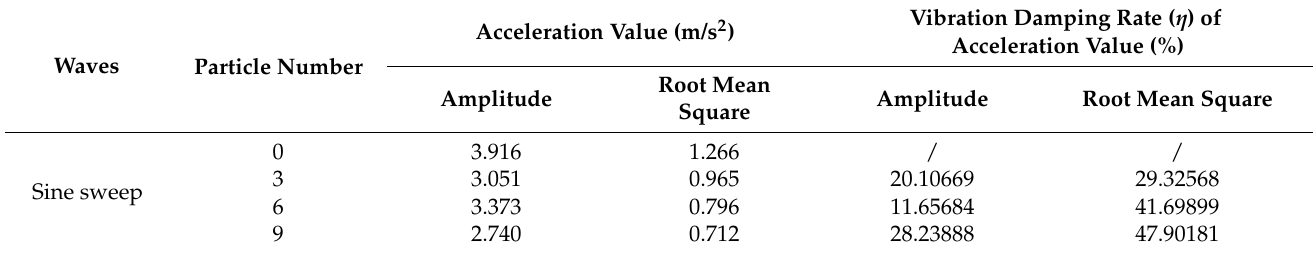
Table 2. Acceleration Response (mass ratio: